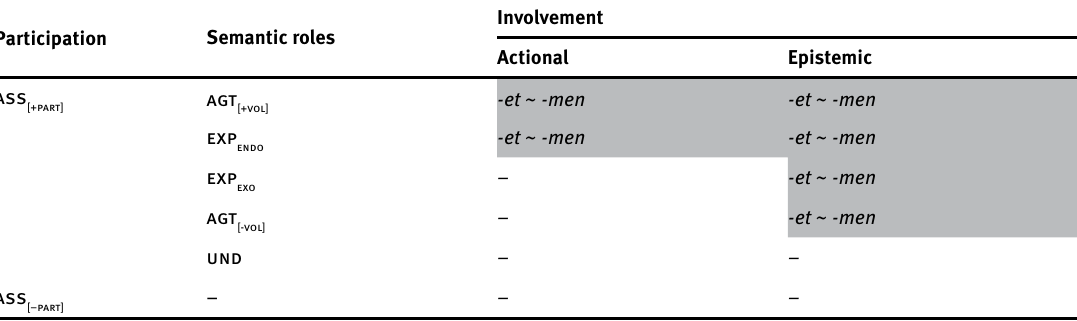
Figure 7. Modeling Bunan past egophoricity markers (innovative)